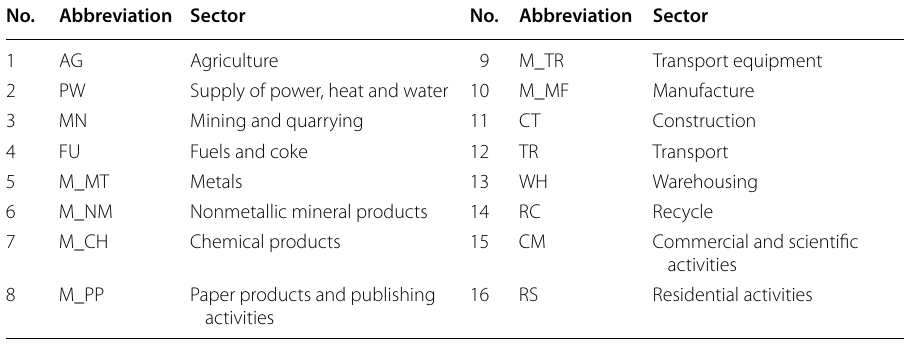
Table 7 Integrated sectors in this paper No. Abbreviation